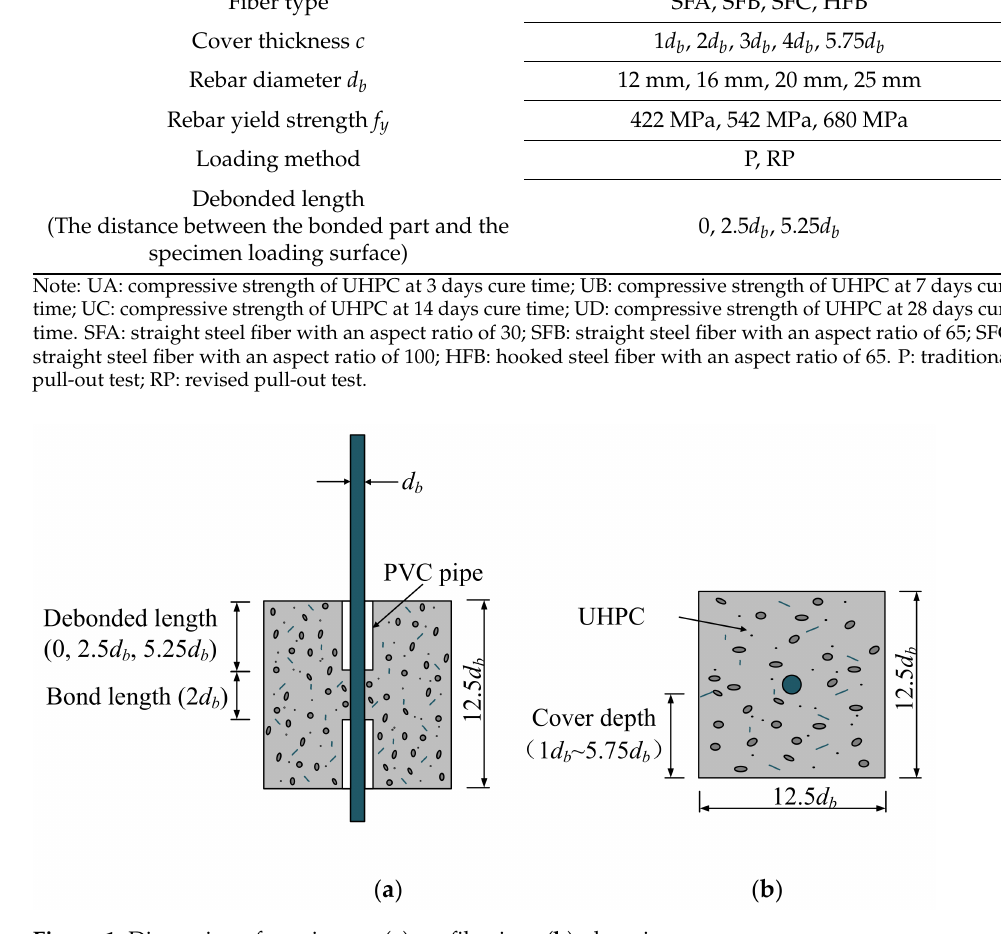
Figure 1. Dimension of specimens: ( a ) profile view; ( b ) plan